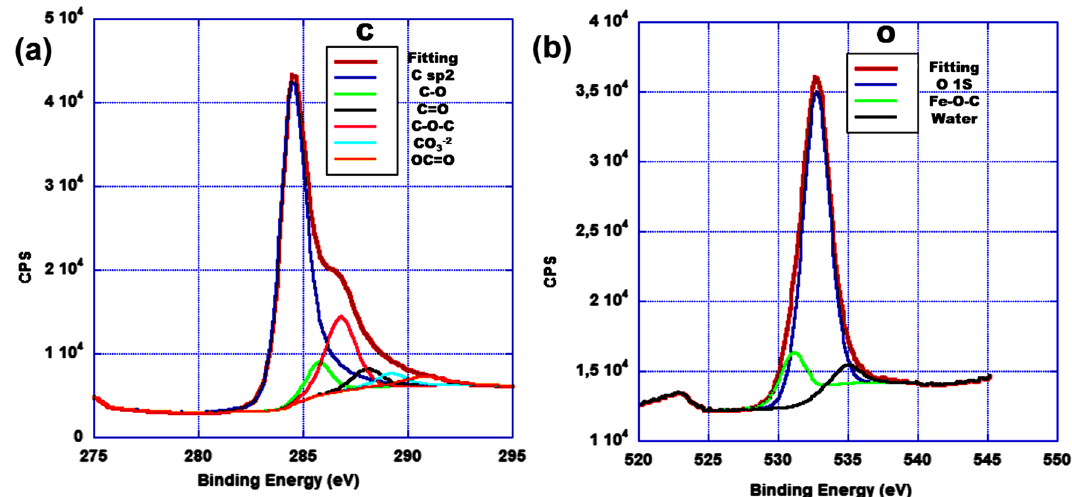
Figure 5. XPS spectra of Ch-rGO/Fe 3 O 4 ( a ) C 1s and ( b ) O 1s core-level spectra.